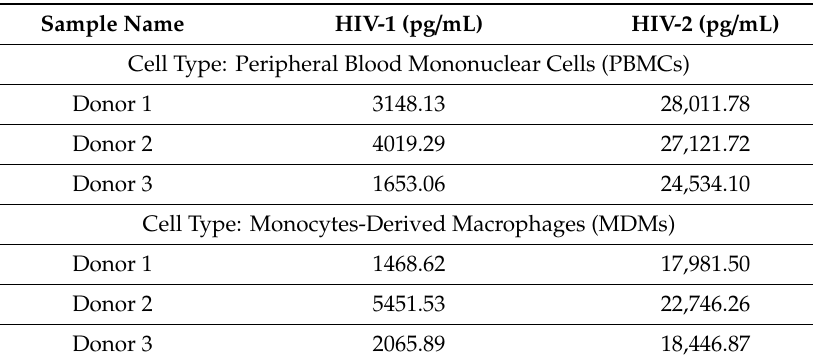
Table 1. Quantification of HIV-1 (P-24) and HIV-2 (P-27)